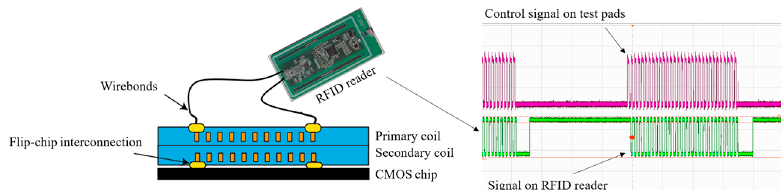
Figure 5. Schematic of telemetric readout setup with microcoil acting as primary coil (reader antenna), RFID reader and telemetrically extracted digitized signal representing the sensor